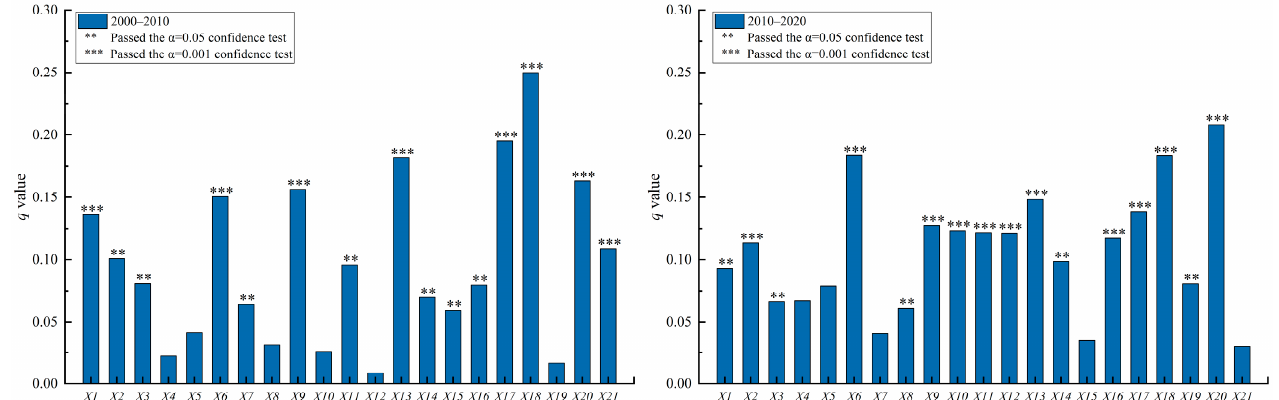
Figure 6. Contribution rate of influencing factors of population shrinkage in the North–South Tran- sitional Zone of China by time period.